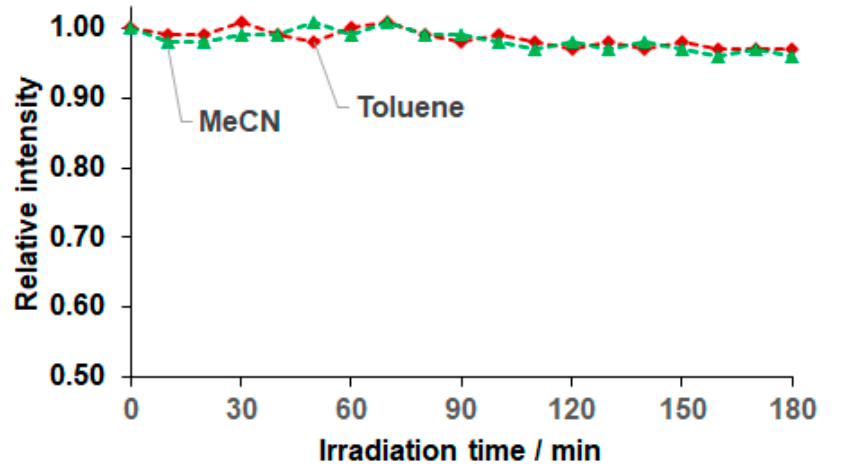
Figure 2. The photostability of BODIPY 1 in toluene and MeCN under the irradiation of a 150 W xenon lamp.